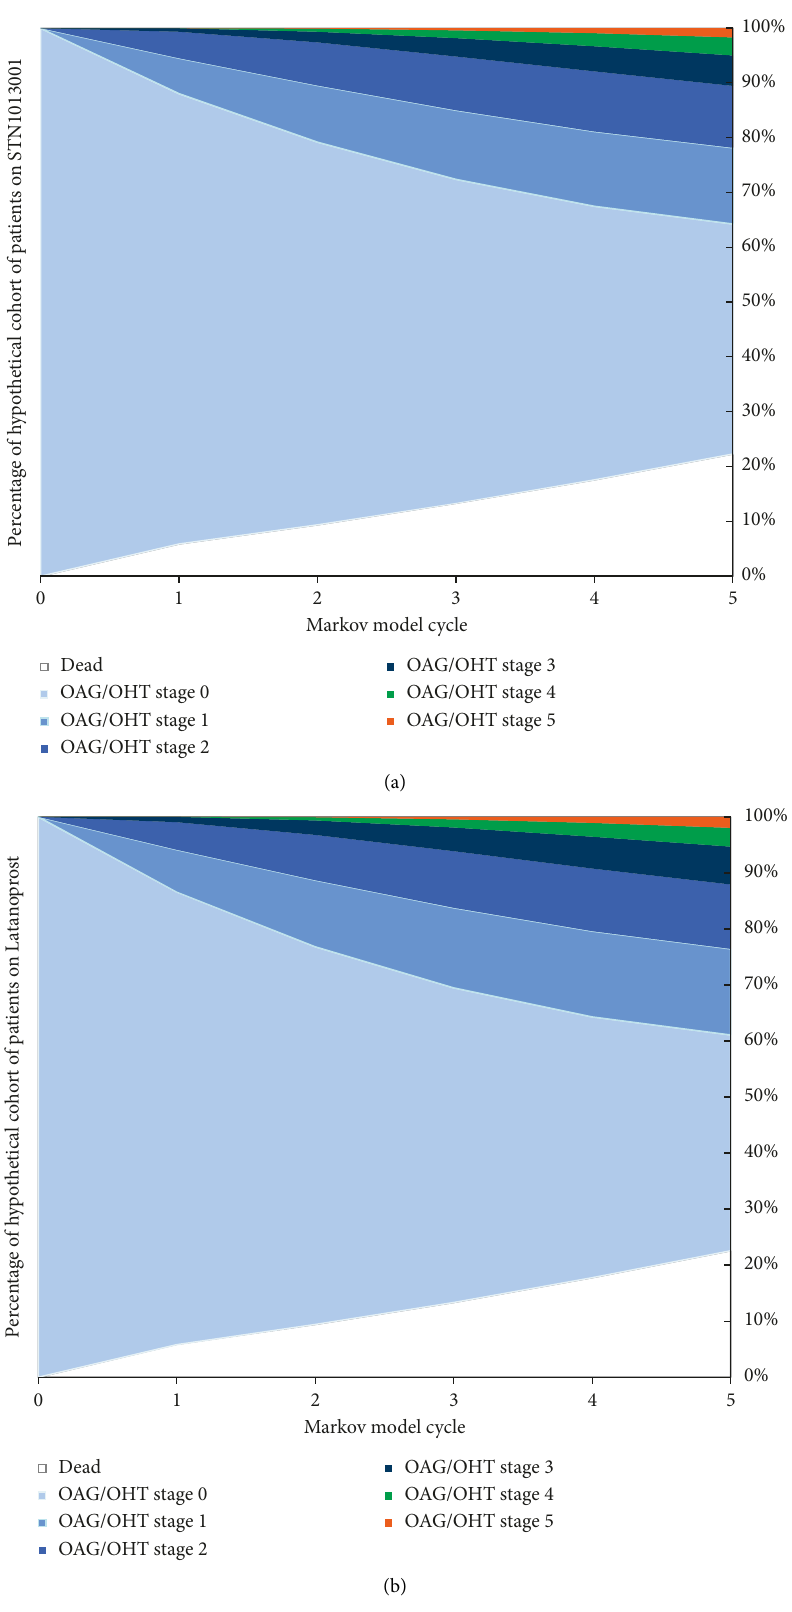
Figure 2: (a) Base case analysis–results–Markov trace–hypothetical cohort of patients on STN1013001. (b). Base case ana- lysis–results–Markov trace–hypothetical cohort of patients on Latanoprost. OAG/OHT